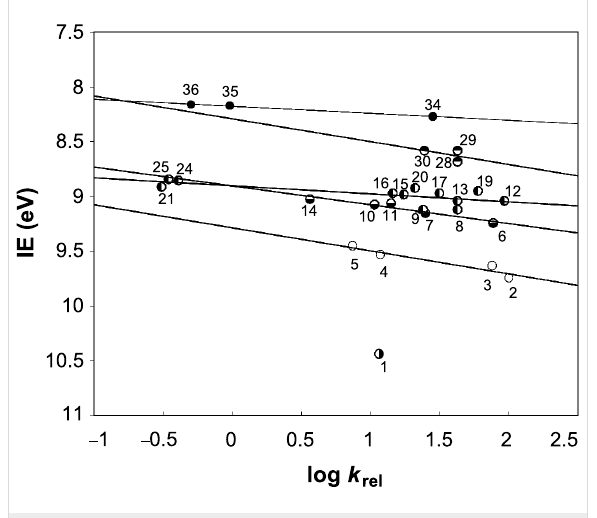
Figure 2: Plot of log k rel values for PhSeCl addition to alkenes versus their corresponding IEs. Point numbers correspond to entries in Table